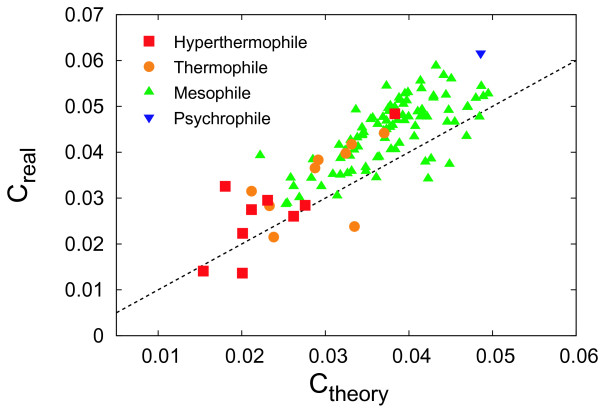
Comparison of the average clustering coefficient C between our model (theory) and real metabolic networks (real). The dashed line shows Creal = Ctheory.